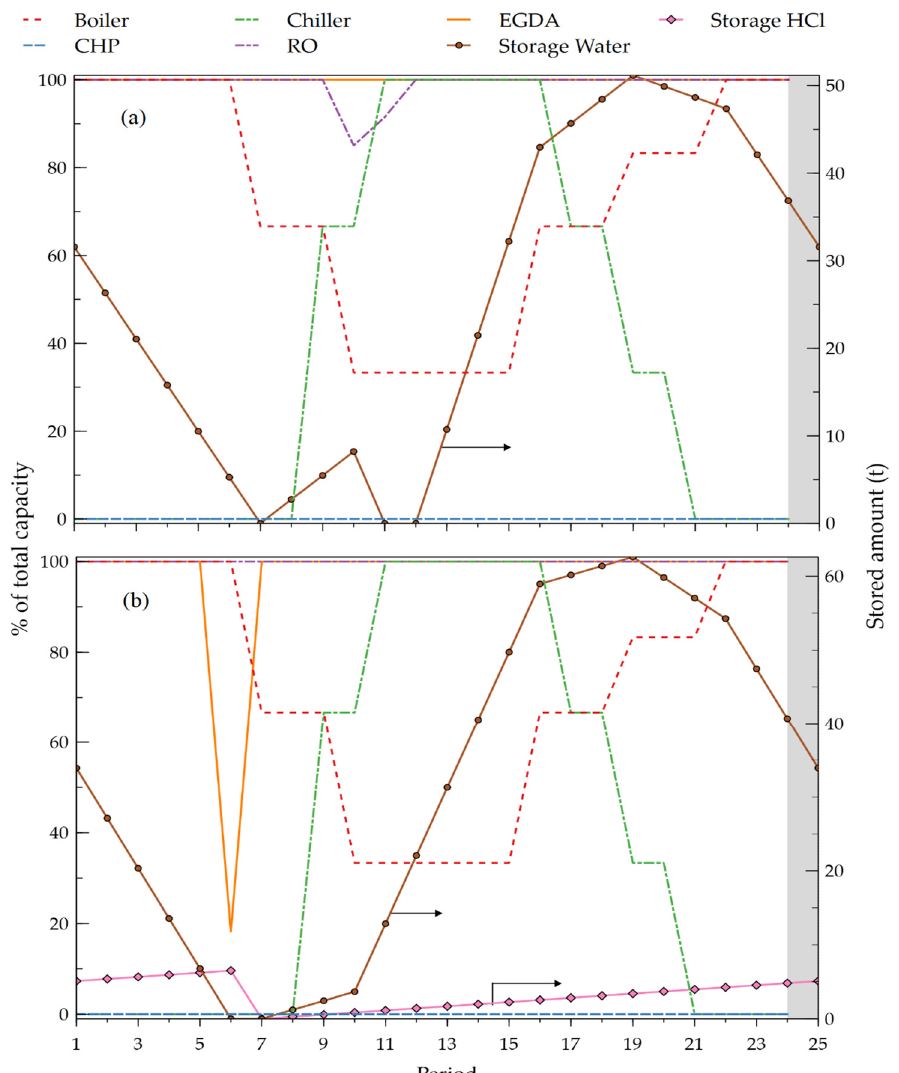
Figure 8. The operating state of the units for the different periods in two alternative solutions with no CO 2 limitation: ( a ) solution 6, ( b ) solution 66. no CO 2 limitation: ( a ) solution 6, ( b ) solution